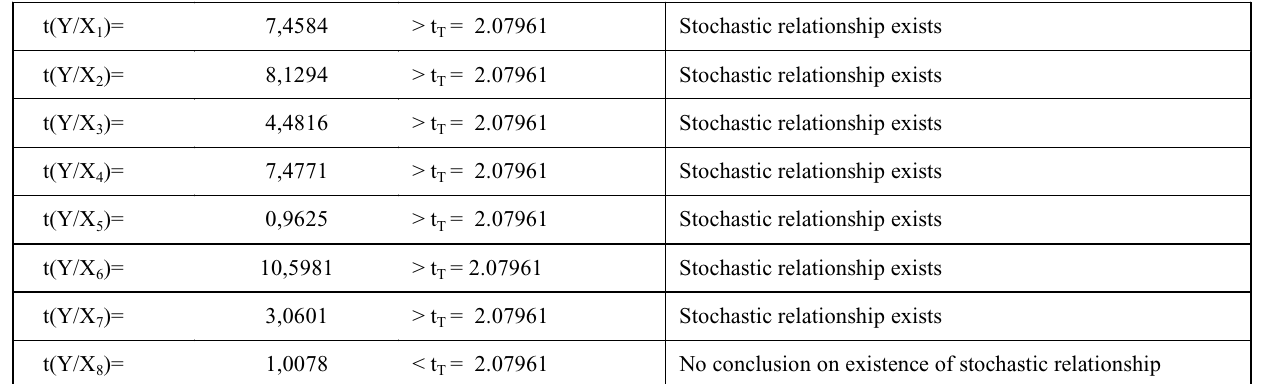
Table 3. Comparison of calculated and critical value of Student criterion